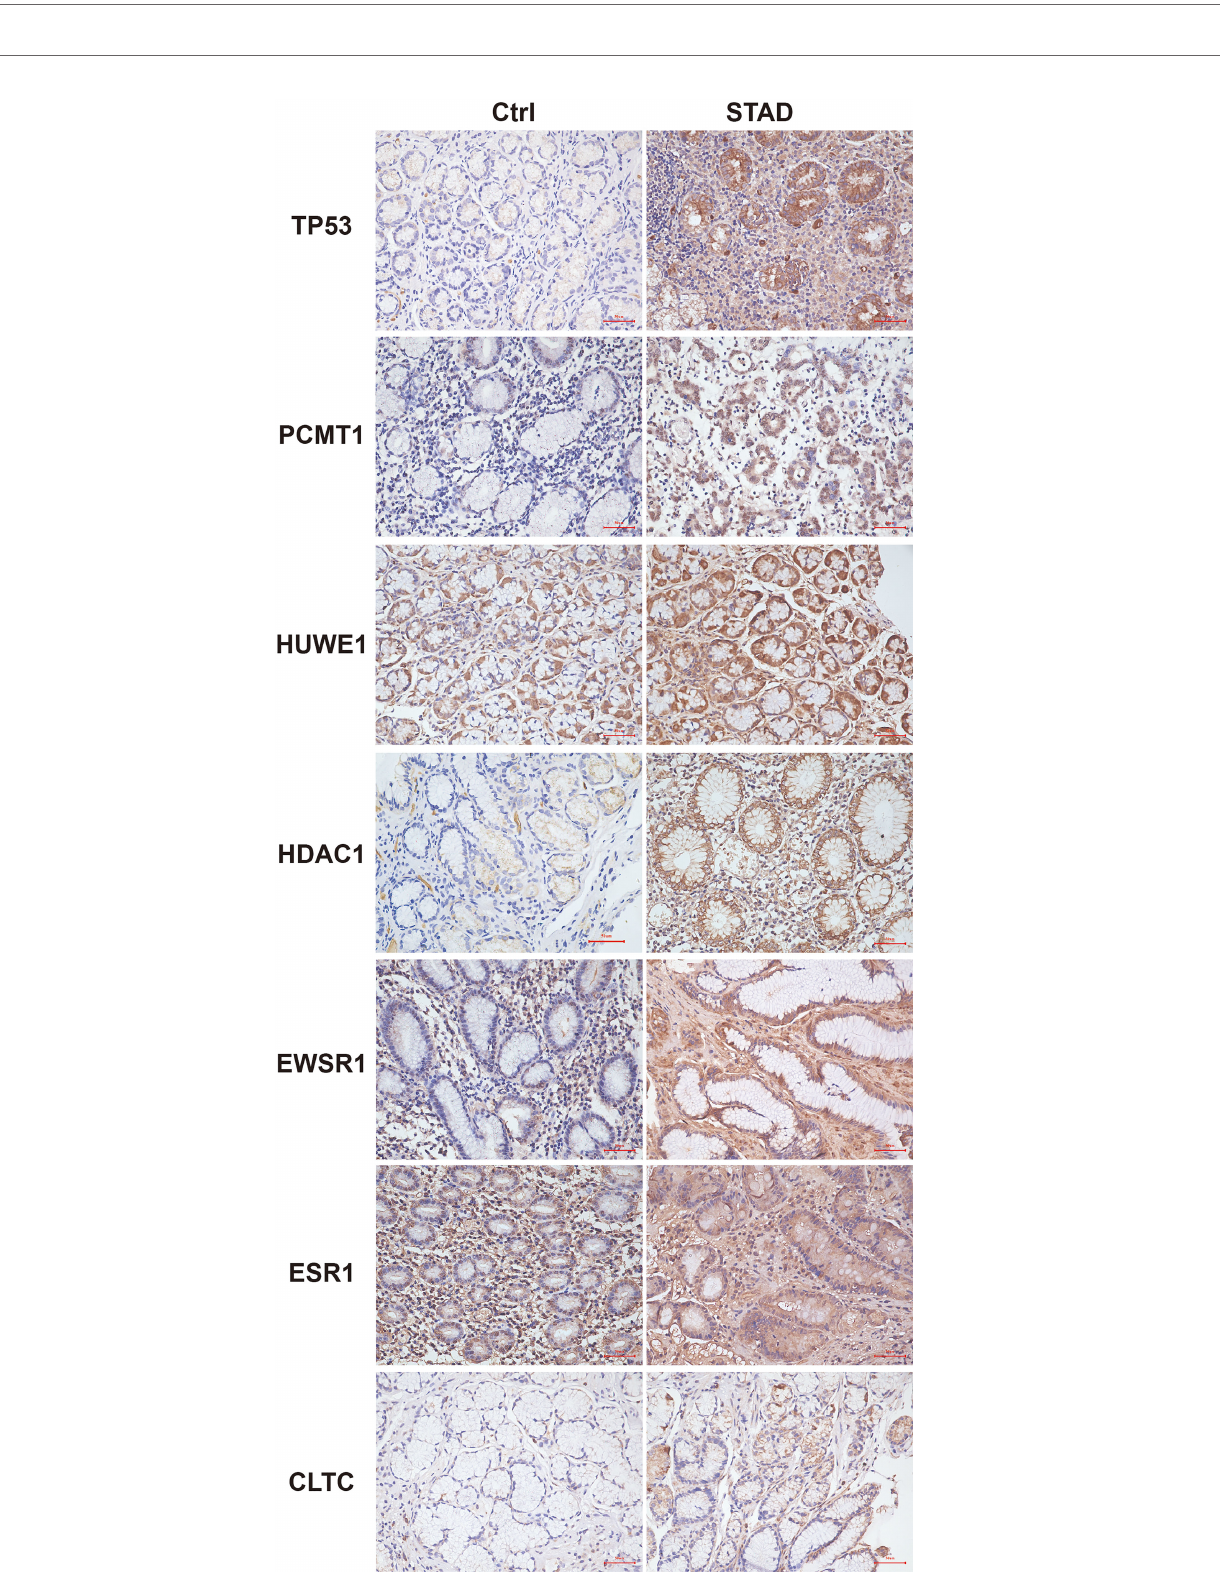
Frontiers in Oncology |